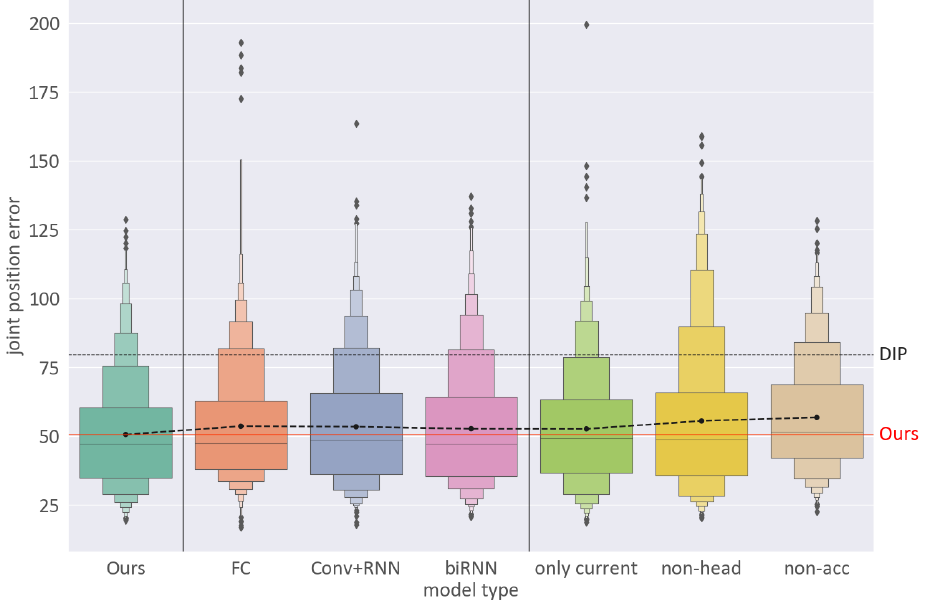
Figure 6. An evaluation of the mean per joint position error. The graph shown here is based on Table 1. We recorded the errors in each frame and showed that our network achieved a better performance than the other variants and DIP [15].